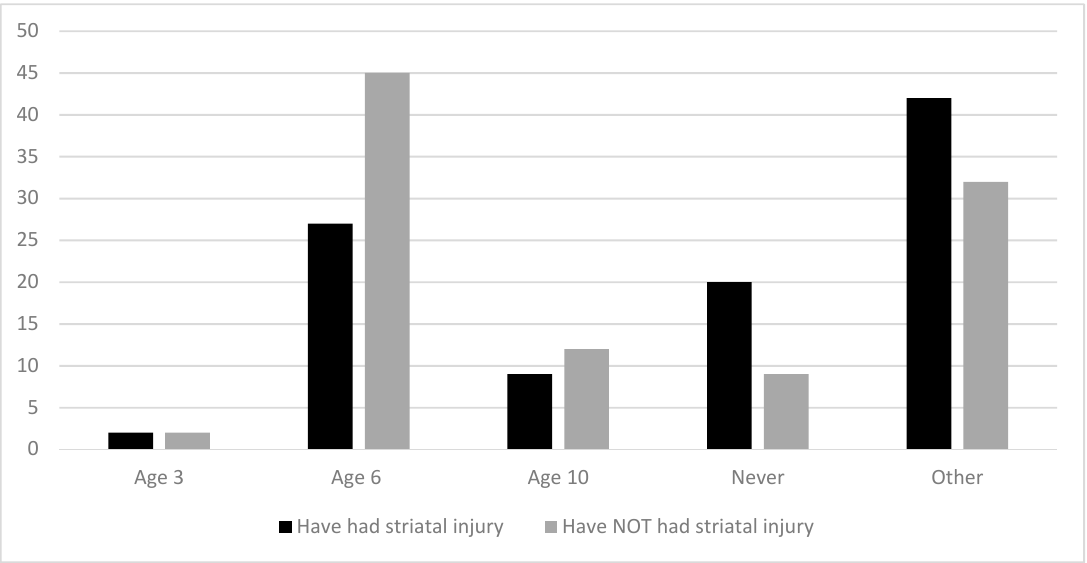
Figure 2. Recommended age of diet liberalization for patients with GA-1 injury (% of survey responses for each age category).